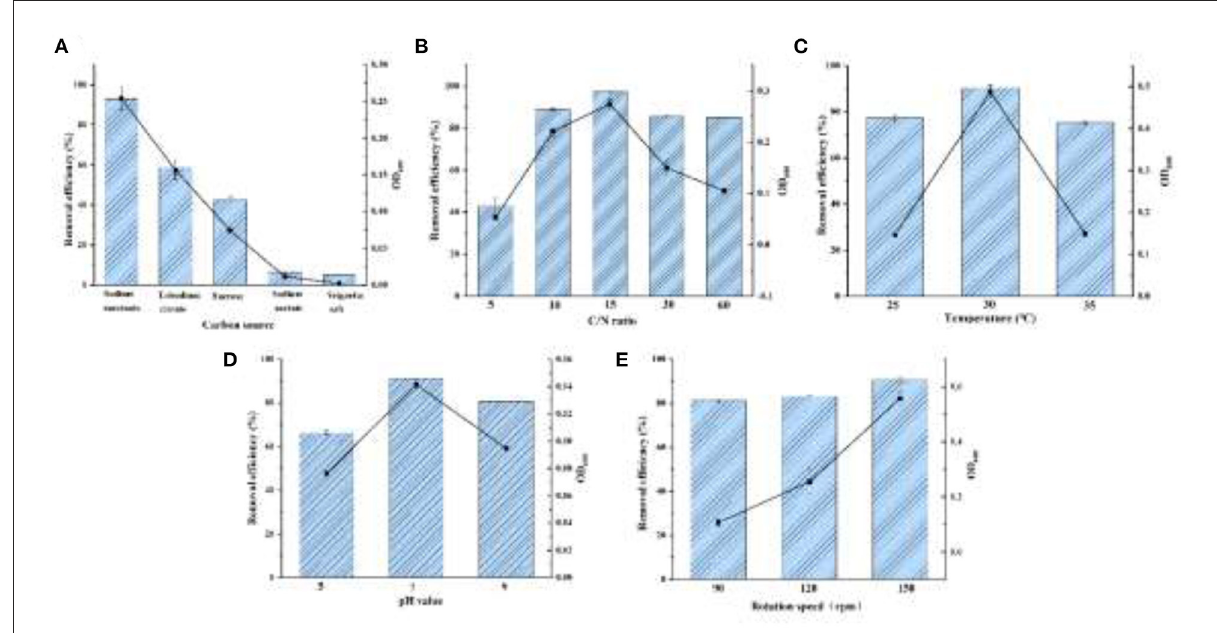
FIGURE4 The effects for denitrification capacity by the conditions of carbon source (A) , C/N ratio (B) , temperature (C) , pH (D) , and DO (E)